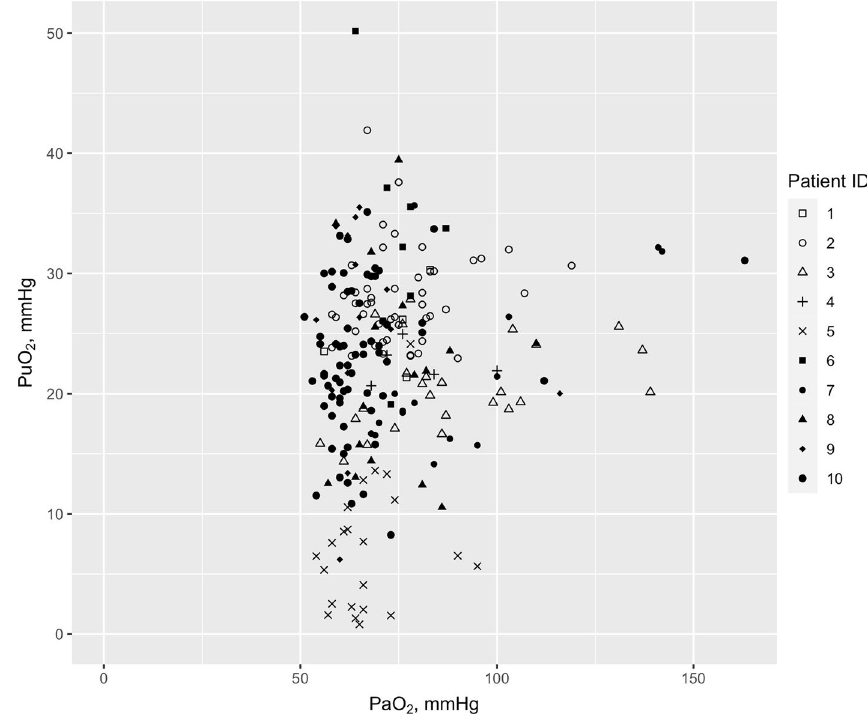
EtCO2: end-tidal carbon dioxide; MV: mechanical ventilation